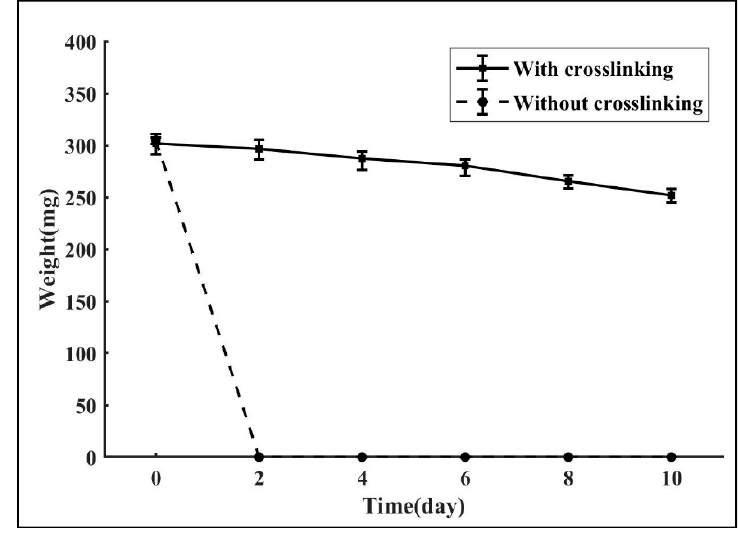
Figure 11. In vitro degradation of the TEVG with and without